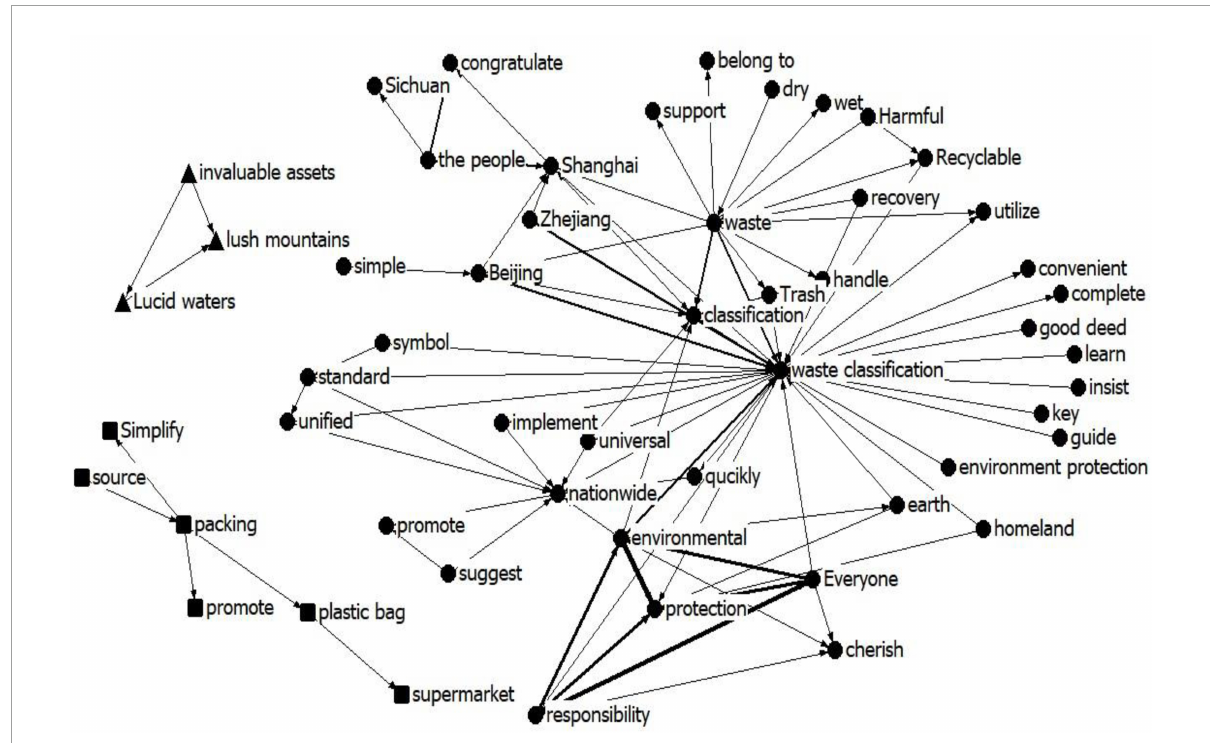
FIGURE8 Positive affective semantic network diagram.